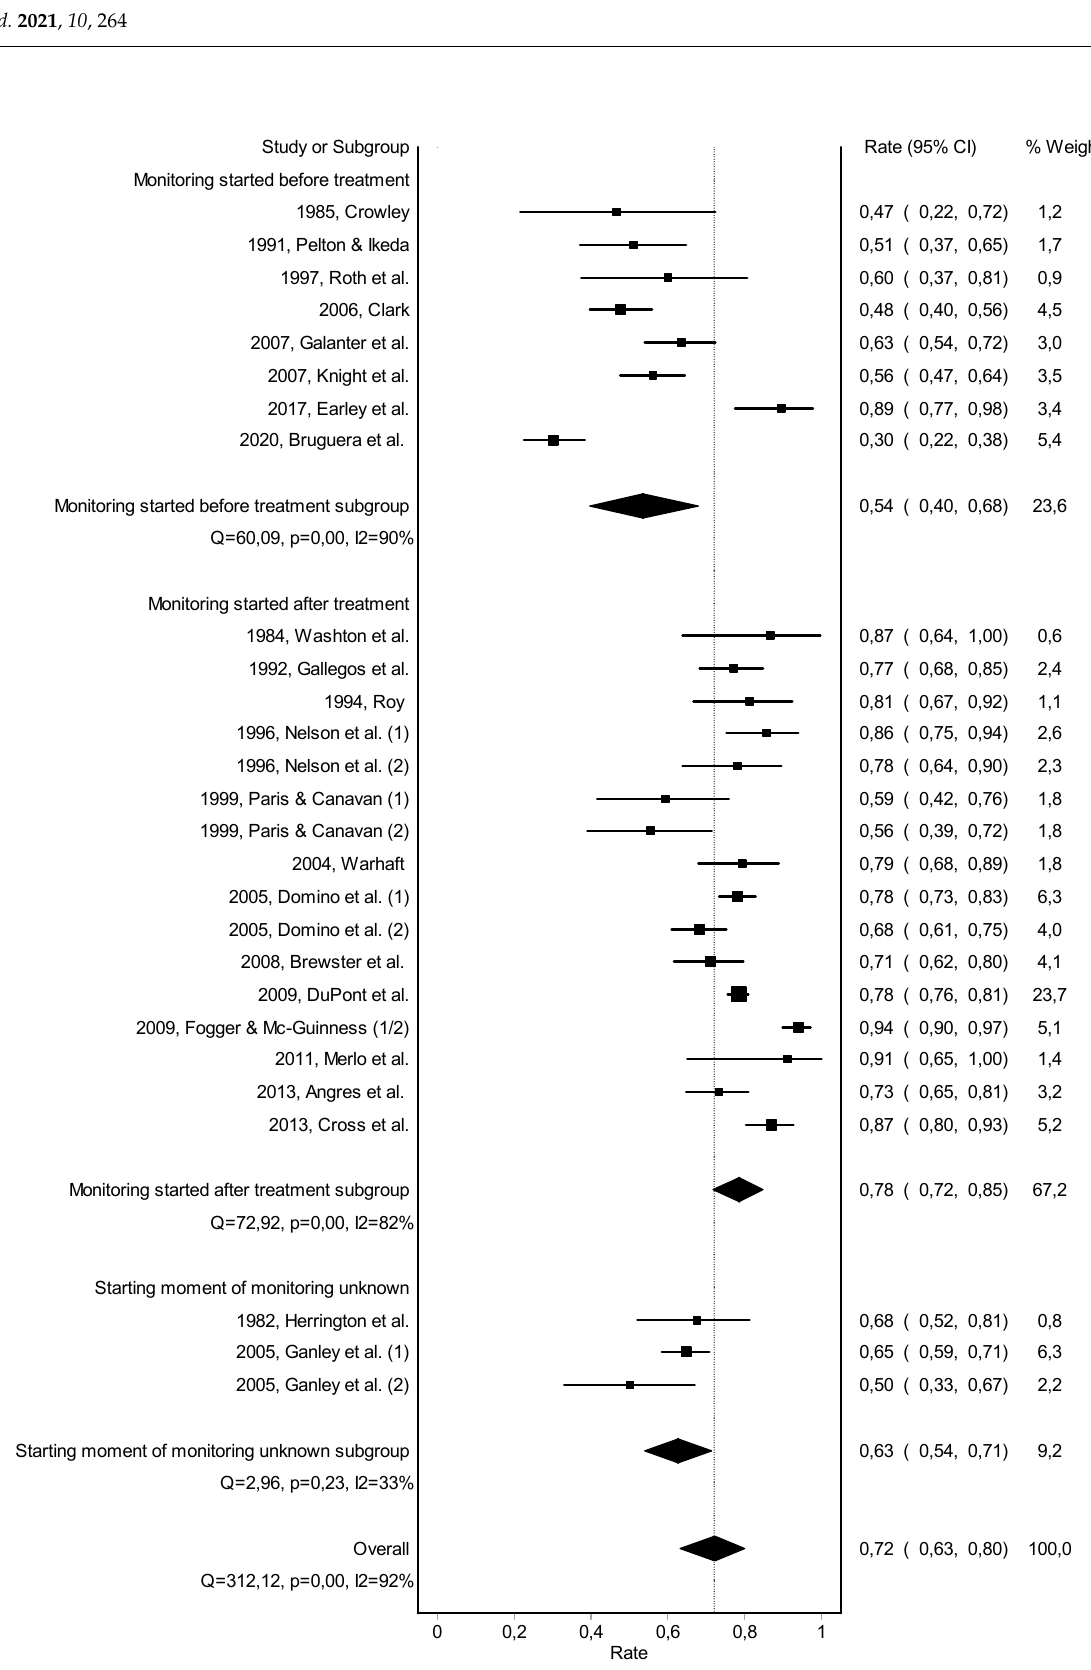
Figure 2. Forest plot of the pooled abstinence rate—subgroup analysis based on starting moment of monitoring.